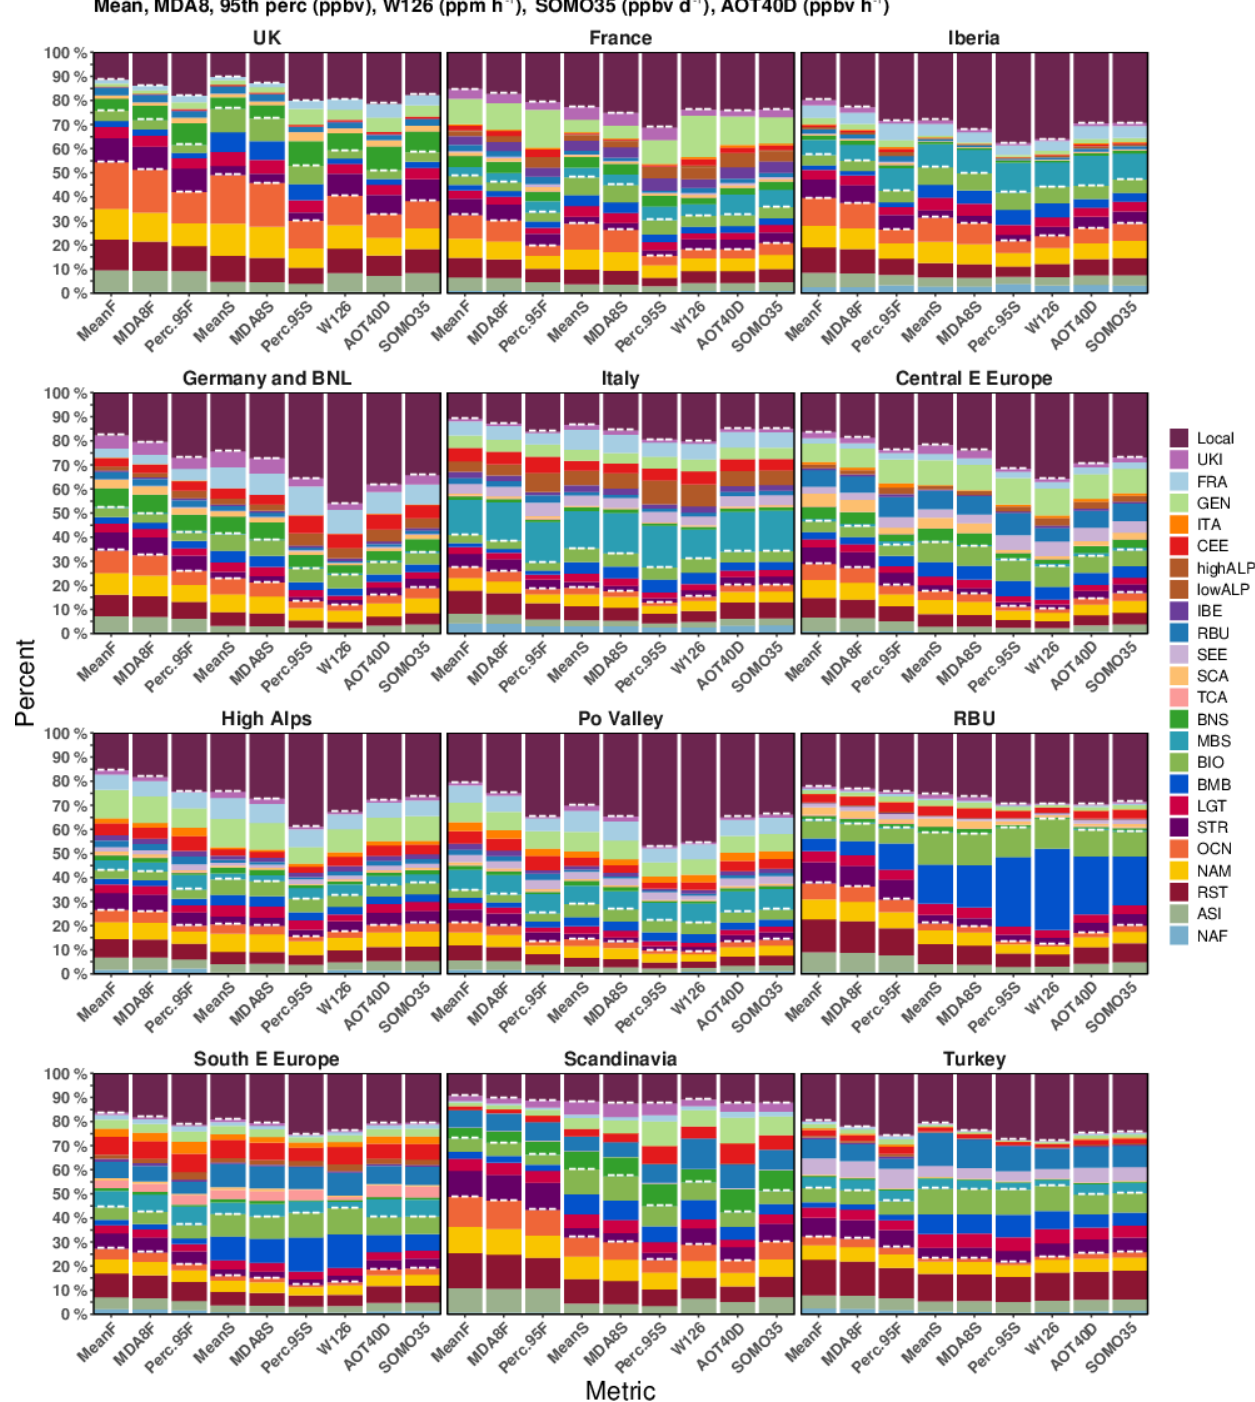
Figure 7. Comparison of percent contribution of local and other European sources, HTAP2 source regions, and other global source types to different O 3 metrics. The metrics analysed are mean, MDA8, and 95th percentile (ppb) for the early “F” and late “S” simulation periods, W126 (ppm · h), SOMO35, and AOT40 (ppb · h). The white dashed lines in each panel separate different categories (intercontinental transport, other global source types, and local and other European